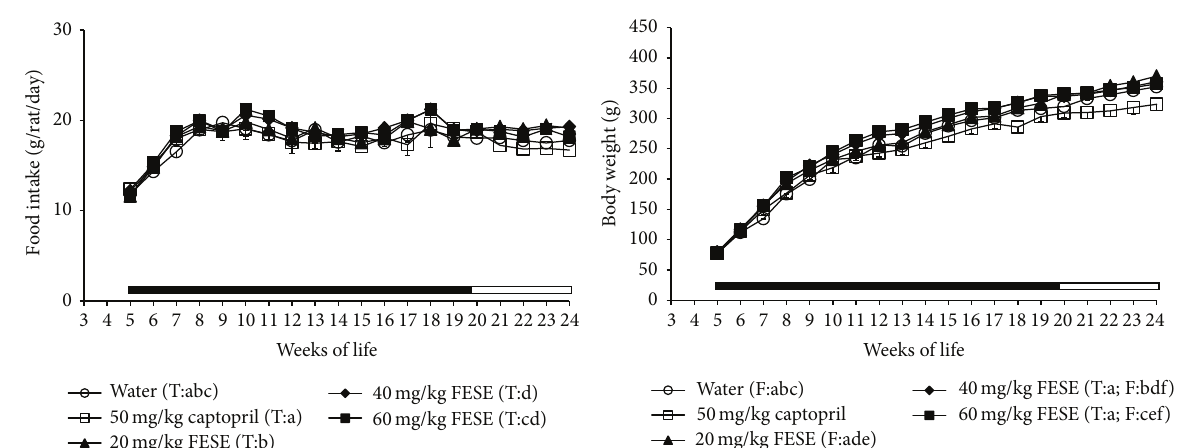
Figure 2: Food intake and body weight of spontaneously hypertensive rats. The animals drank different fluids from weaning until the 20th week of life (treatment period = T, indicated by a solid bar) and received therefore different daily treatments: tap water, 20 mg/kg/day Fraxinus excelsior L. seed extract (FESE), 40 mg/kg/day FESE, 60 mg/kg/day FESE, or 50mg/kg/day captopril. All rats drank tap water from the 20th week of life until the 24th week of life (follow-up period = F, indicated by an open bar). Data are mean values ± SEM for 10 animals in T and for 5 animals in F. Similar letters represent no statistical differences ( 𝑃 > 0.05 ). 𝑃 estimated by two-way ANOVA.